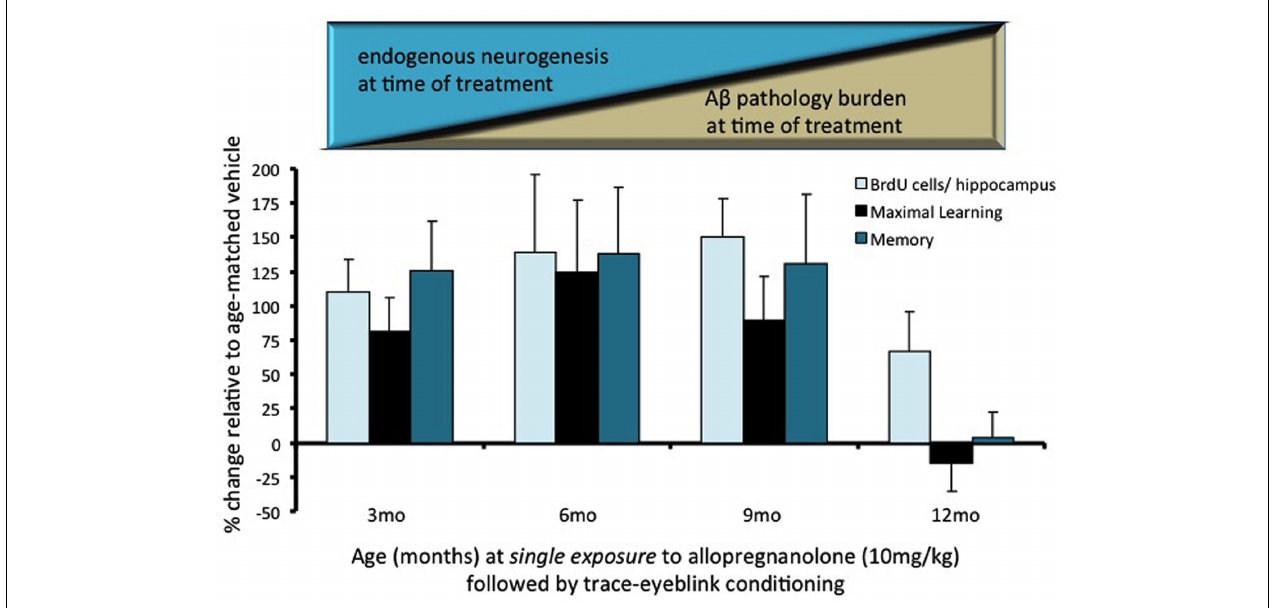
marker BrdU. Bars represent percent change ± sem in response to a single exposure to AP α compared to age-matched vehicle at 3-, 6-, 9-, 12-months of age in 3xTgAD mice ( n ≥ 7;Wang et al., 2010; Singh et al., 2011).Within 3weeks following a single exposure to AP α , neurogenesis, maximal learning, and memory indicators were increased ∼ 100% relative to age-matched vehicle control in adult male 3xTgAD mice when administered at ages prior to overt AD pathology.The 3xTgAD mouse model displays age-associated decrements in endogenous neurogenic cell survival in the subgranular zone (SGZ) as compared with the non-transgenic mice in addition to age-associated increments in A β pathology burden (depicted supra to bar graph). At 12-months of age, intra- and extraneuronal A β 6E10 antibody staining is apparent and plaque structures are developed in subiculum (Wang et al., 2010; Singh et al., 2011).The therapeutic response to AP α was specific to the transgenic AD phenotype, as the age-matched non-transgenic mice did not benefit from a single exposure to AP α . Remarkably, a single exposure to AP α increased neurogenesis and subsequent cell survival in aged non-transgenic mice when administered at 15-months of age (non-Tg data not in figure; Singh et al., 2011). At 12-months of age, the point when extraneuronal plaques are known to be present in this AD mouse model, a single exposure to AP α was ineffective. At ages prior to extraneuronal A β plaques, AP α significantly ( P < 0.05) increased BrdU + cell survival, maximal learning, and memory function relative to age-matched vehicle